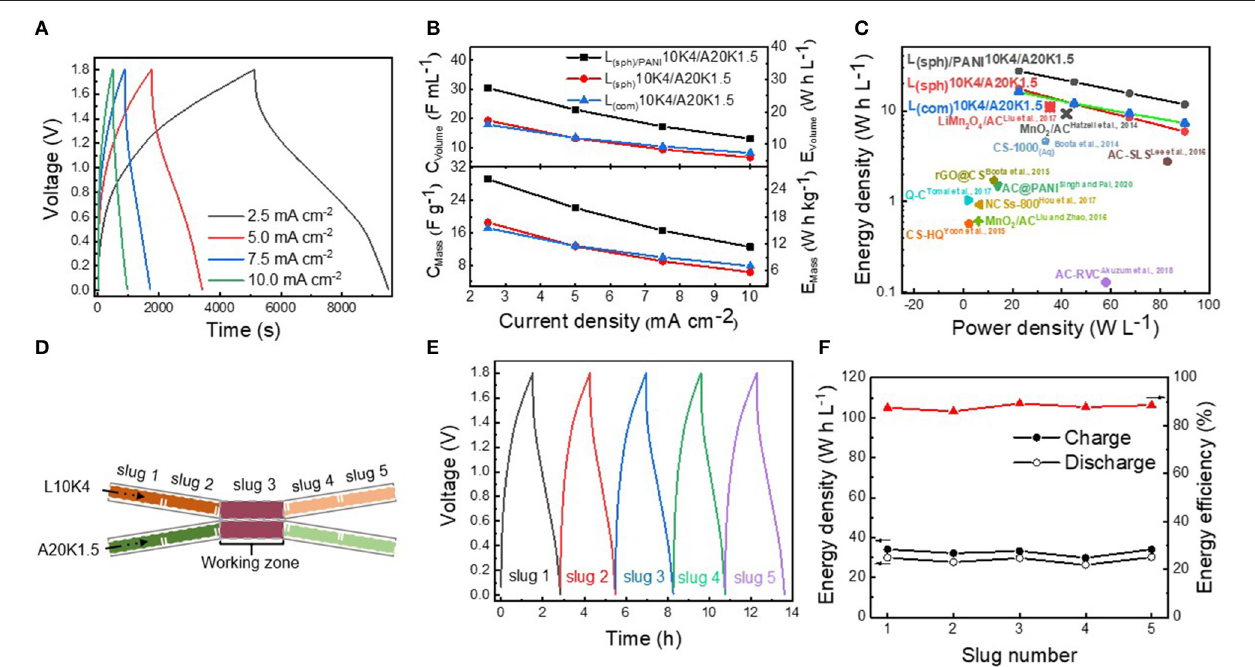
FIGURE 5 | (A) Charging/discharging profiles of the L (sph) / PANI 10K4/A20K1.5 static cell tested at different current densities in the voltage range of 0.0–1.8V. (B) Specific capacitances (C Mass ) and volumetric capacitances (C Volume ) and (C) Ragone plot of L (sph) / PANI 10K4, L (sph) 10K4, and L (com) 10K4/A20K1.5 static cell obtained at different current densities and the comparison with most other types of flow capacitors reported in literature. (D) Schematic of intermittent-flow tests of L10K4/A20K1.5 flow Li-ion capacitor. (E) Charging/discharging curves for five injections of suspensions tested at current density of 2.5mA cm − 2 . (F) Energy densities and energy efficiencies of this Li-ion flow capacitor under the intermittent-flow